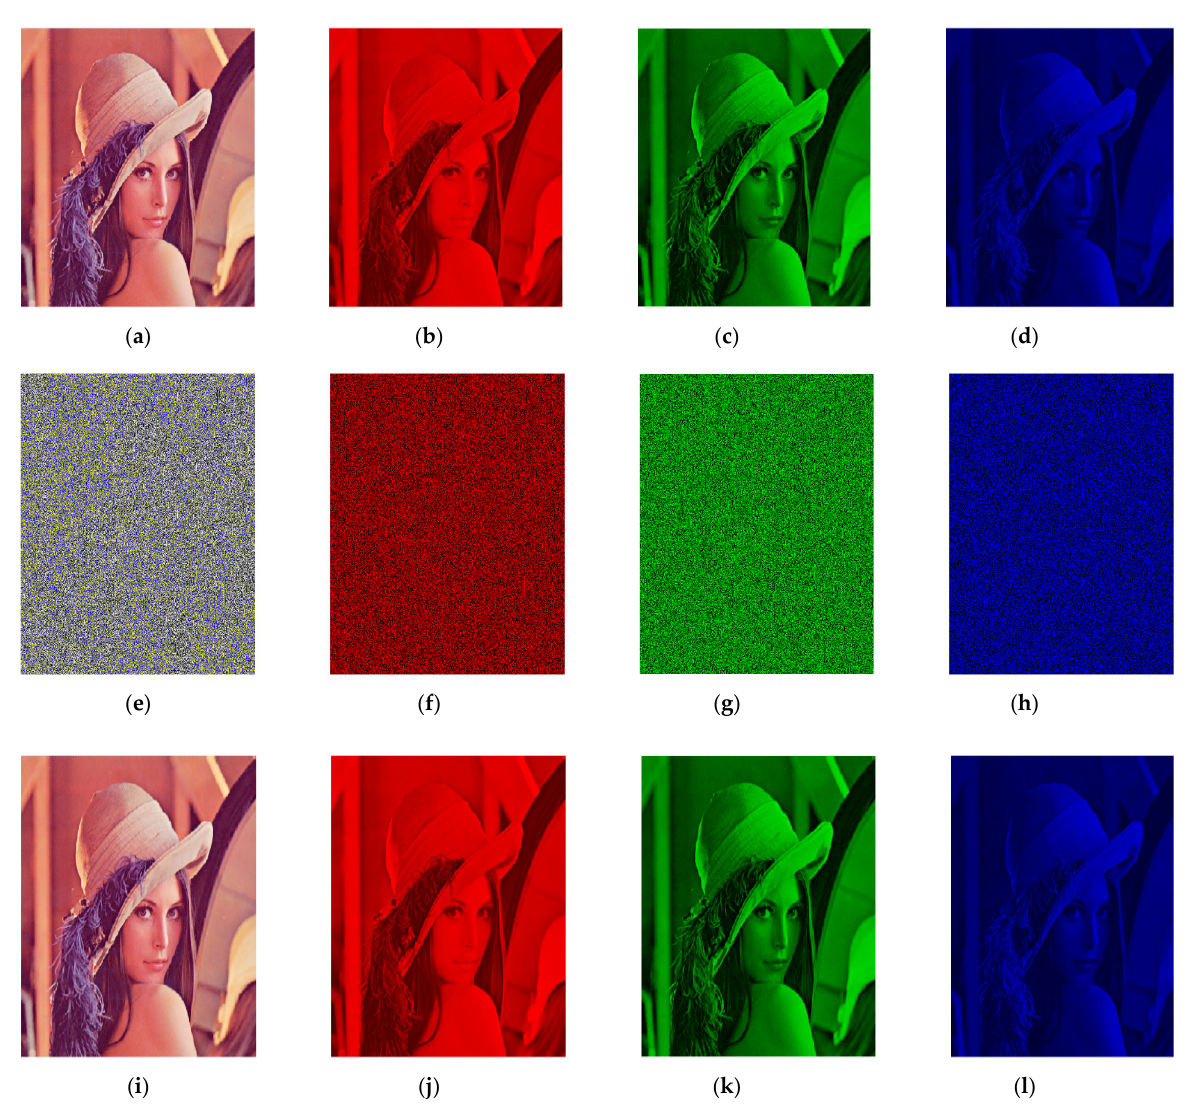
Figure 15. Experimental results of a plain “Lena.png” 512 × 512 color image: ( a ) the original image, ( b ) R band, ( c ) G band, ( d ) B band, ( e ) encrypted Lena image, ( f ) encrypted R band, ( g ) encrypted G band, ( h ) encrypted B band, ( i ) recovered (decrypted) Lena image, ( j ) recovered R band, ( k ) recovered G band, ( l ) recovered B band.